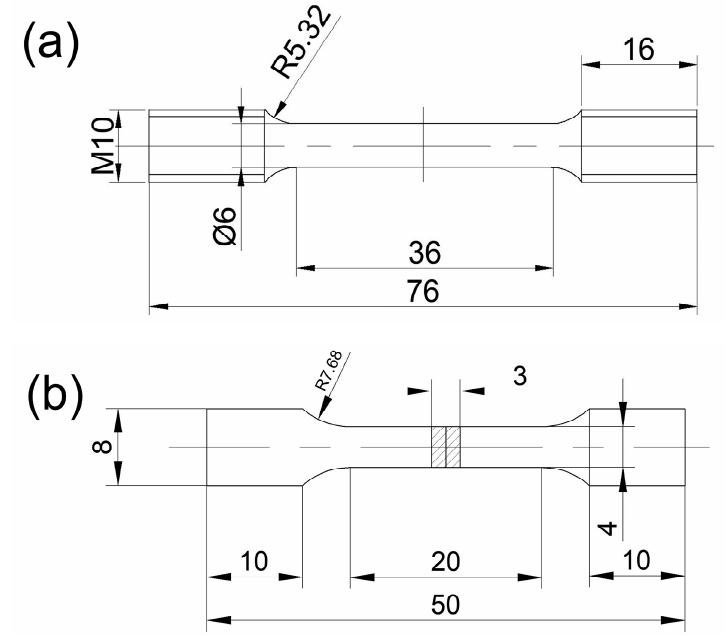
Figure 1. The mechanical drawing of the tensile creep sample and tensile sample (unit is millimeter).